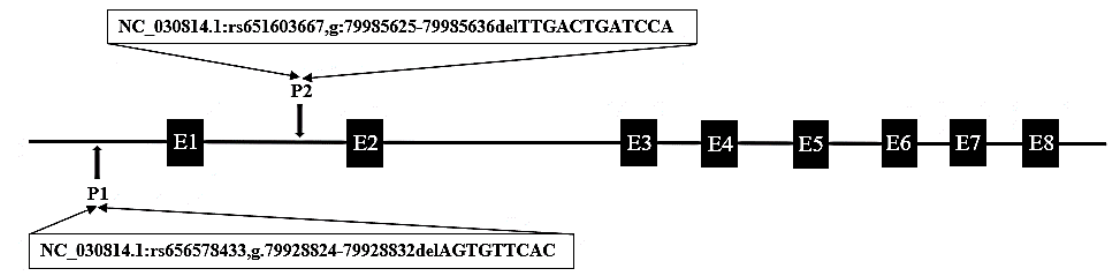
Figure 1. Mode pattern of goat PRDM6 gene variations position. The black arrows represent the mutation positions; the black boxes represent the number of exons of the goat PRDM6 . Table 1. Designed primers used for detecting deletion mutations of the goat PRDM6.